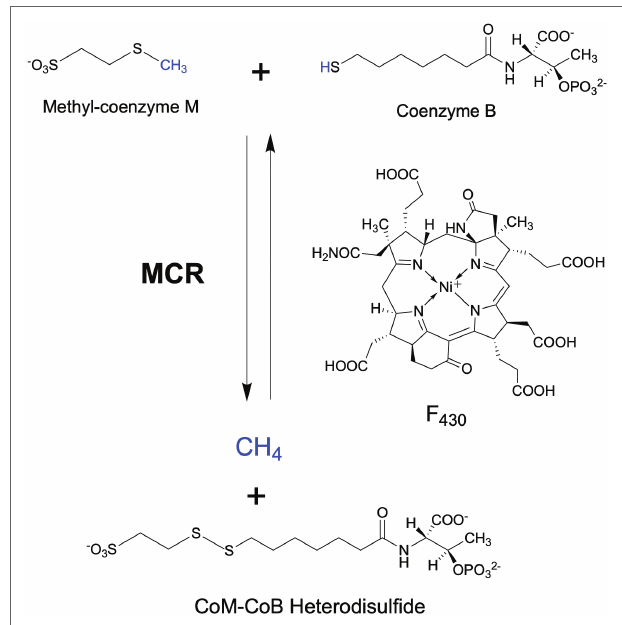
FIGURE 1 | MCR-catalyzed reactions in the final step of methanogenesis in methanogens and the first step of the anaerobic oxidation of methane in anaerobic